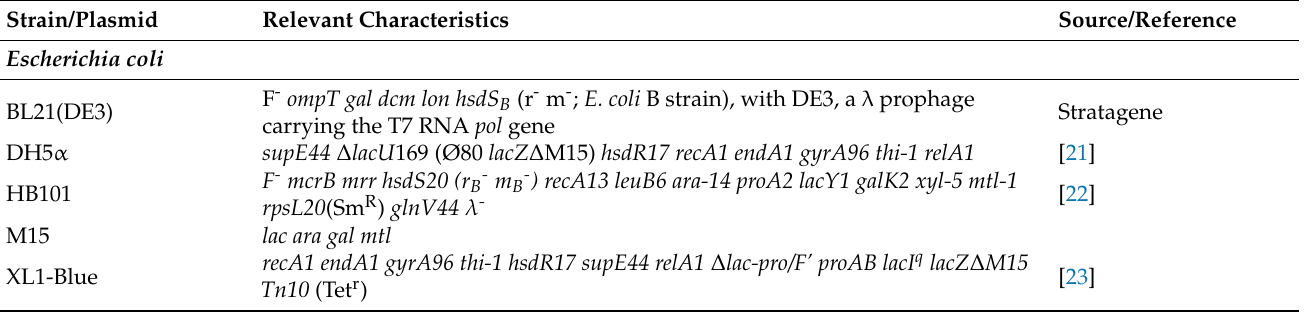
Table 1. Microbial strains and plasmids used in this study.